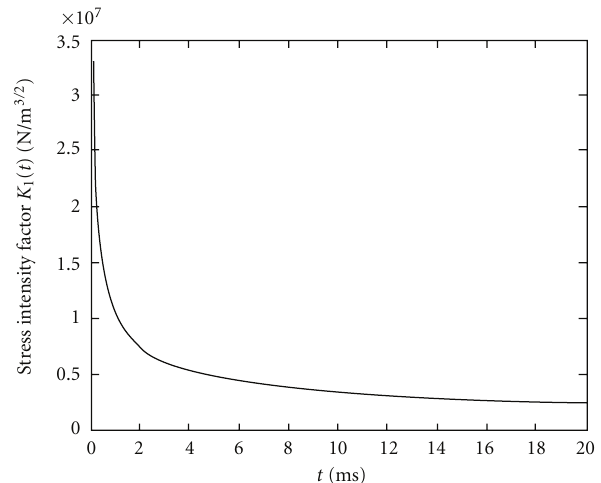
Figure 4: Dynamic stress intensity factors versus time.